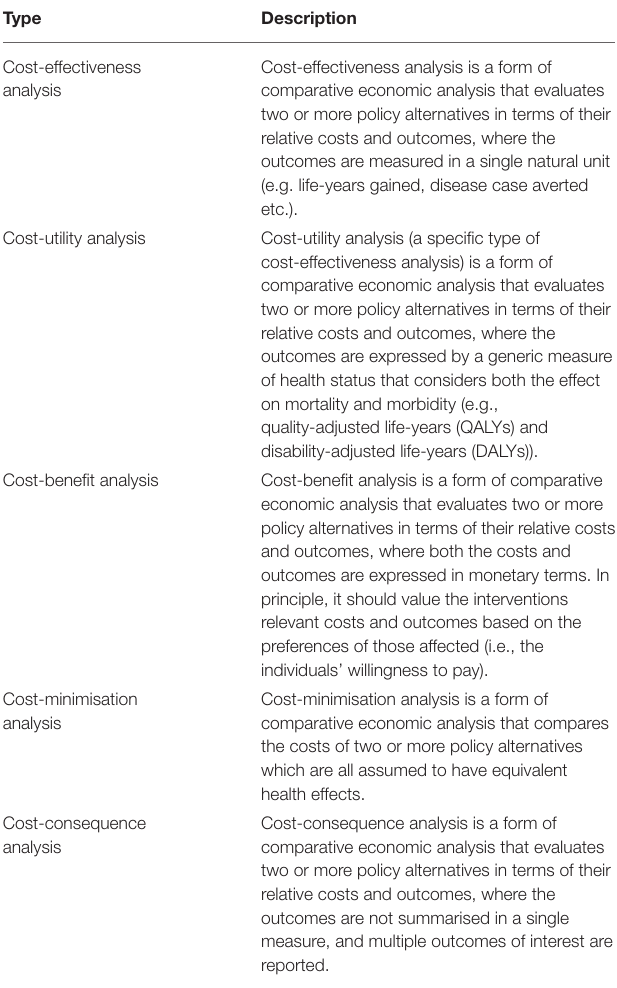
TABLE 1 | The key types of full economic evaluations